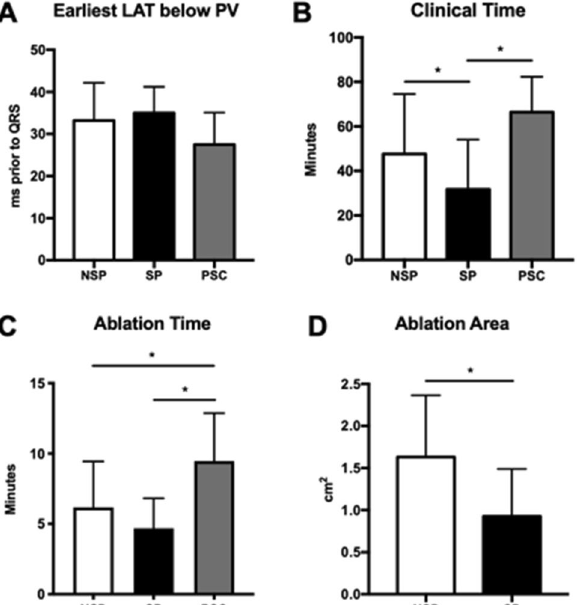
Figure 3. The influence of the special potential appearance to multiple mapping and ablation parameters including: ( A ) Earliest LAT at the site below the PV; ( B ) clinical time of the whole procedure; ( C ) total ablation time; ( D ) ablation area. NSP = Group of VAs with no special potential; NSP = Group of VAs with special potential; VAs of both NSP and SP group were successfully ablated below PV. PSC = Group of VAs that were finally eliminated in PSC. For all figures, * p <